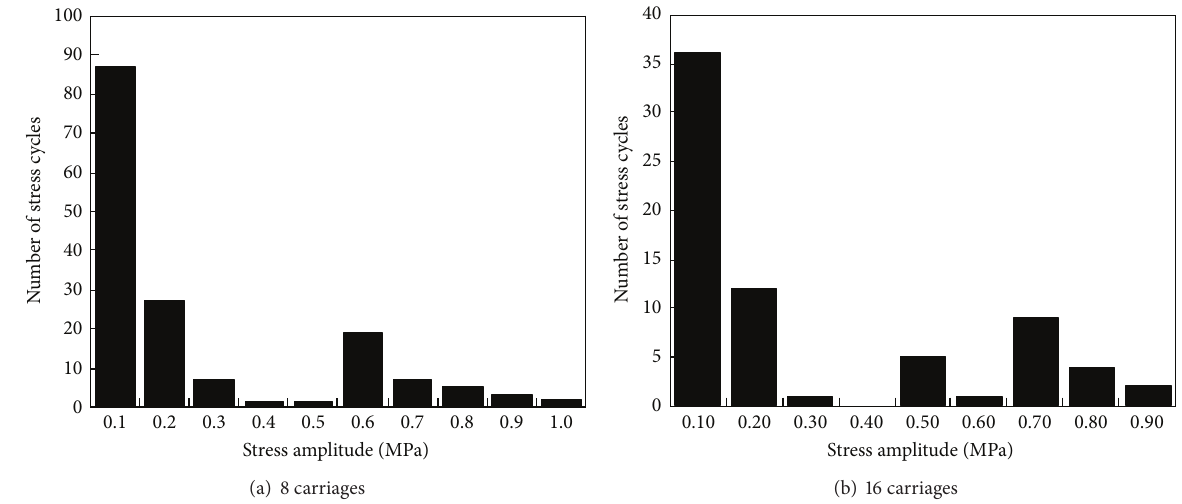
Figure 21: Spectra of stress amplitude calculated using the strain history